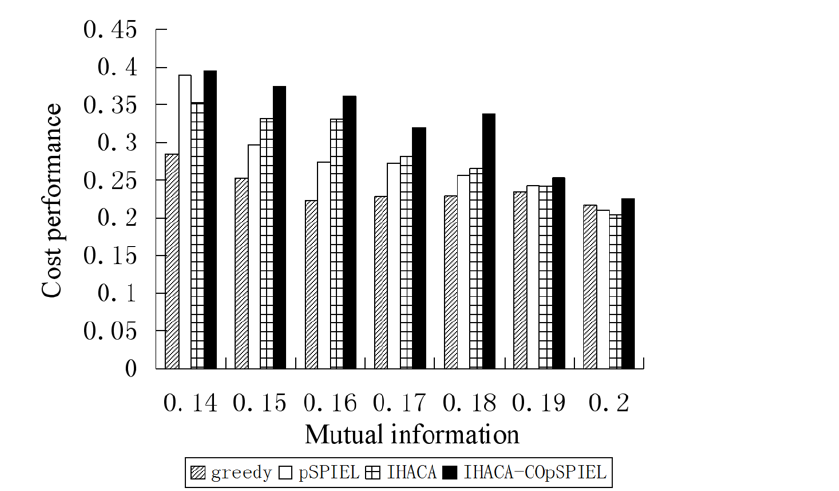
Figure 2. Cost performance and mutual information of the four